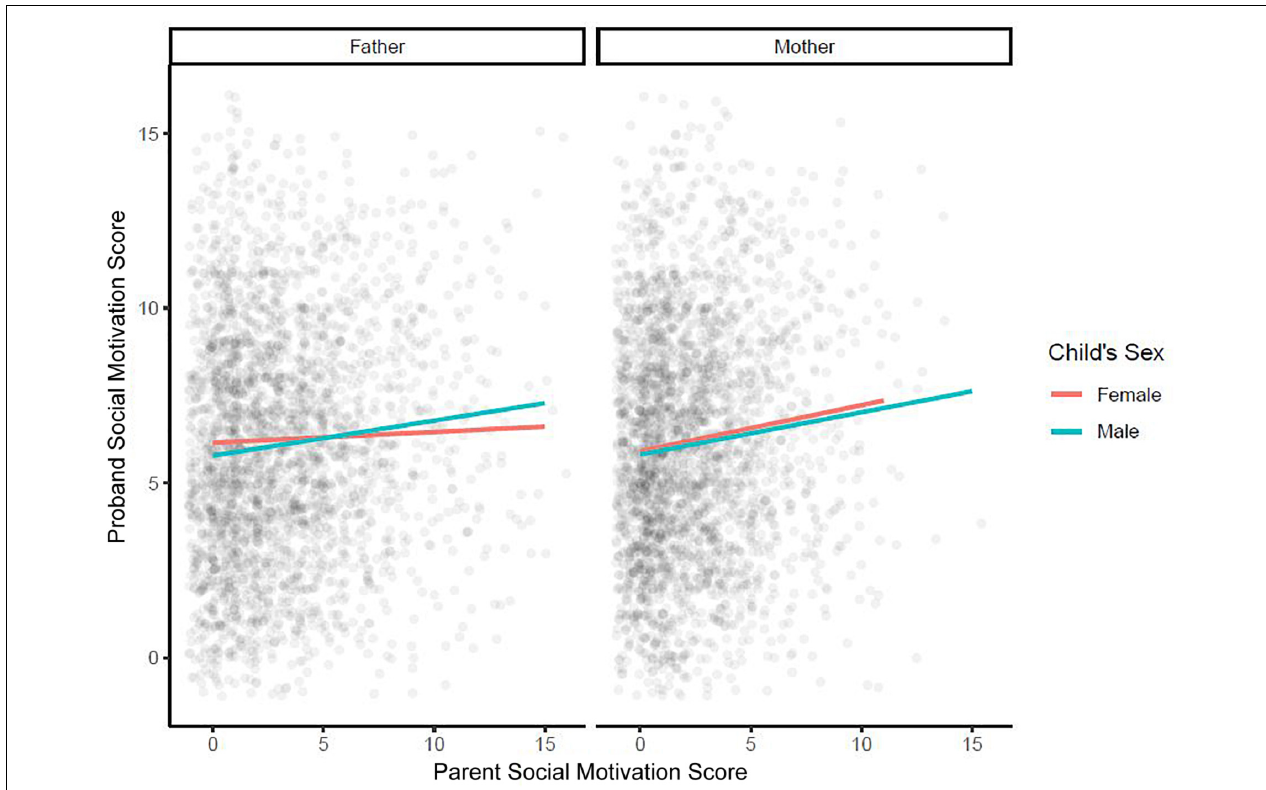
FIGURE 3 | Multiple regression model examining whether the effect of each parent’s social motivation on a child’s social motivation depends on a child’s sex. SM, social motivation.